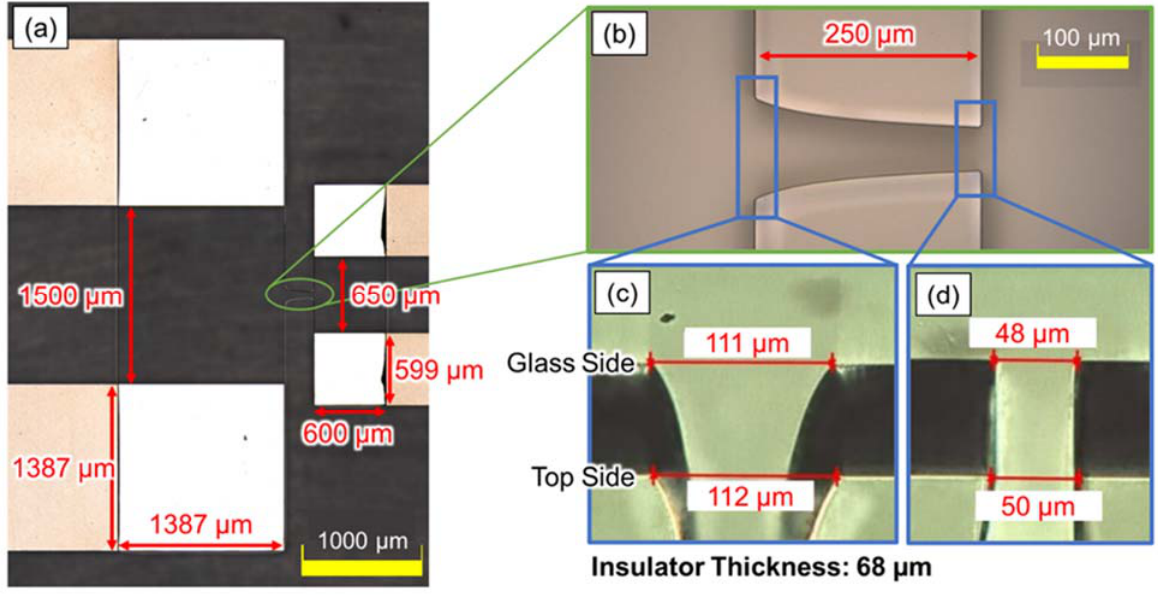
Figure 6. Microscope image of the fabricated device. The shape of the fabricated device was mostly consistent with the designed parameters shown in Figure 4. ( a ) The entire chamber of the device, with the objective lens focused on the electrode. ( b ) The enlarged image of the creek-gap insulator, with the objective lens focused on the top of the insulator. ( c ) The depth synthetic image of the narrower insulator gap. ( d ) The depth synthetic image of the wider insulator gap.